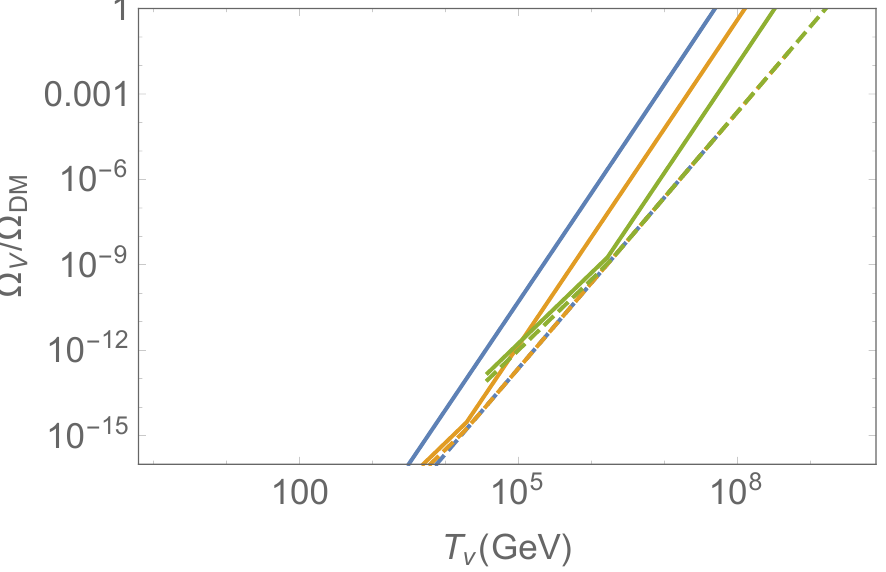
Figure 12 . The relic abundance of the vorton, Ω v / Ω DM , in terms of the vorton formation tem- perature T . The blue, orange and green lines corresponds to f v solid line assumes vortons never annihilate after being formed. The dashed line assumes vortons efficiently annihilate and only the asymmetric component remains. The blue dashed line is over- lapped by the orange dashed line. See the